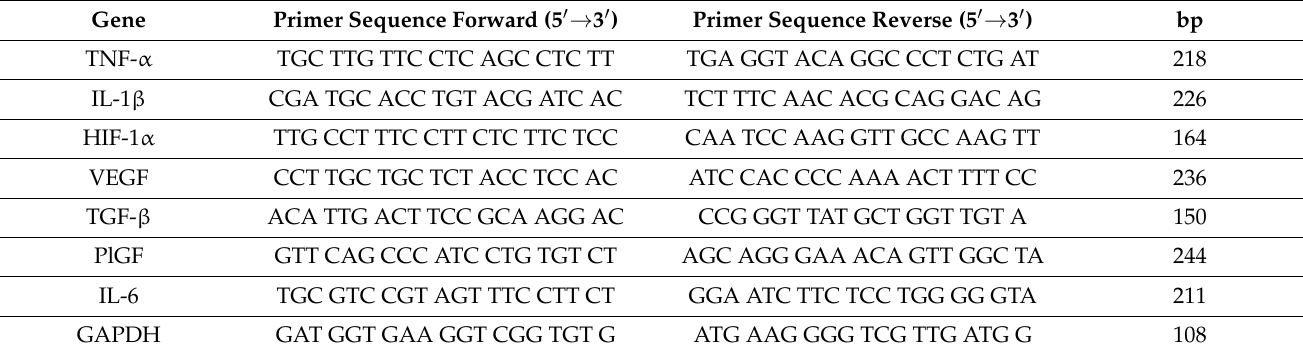
Table 4. Sequences of primers used for RT-PCR